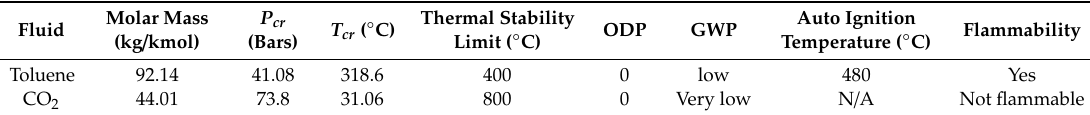
Table 1. Thermodynamic and HSE characteristics of pure CO 2 and